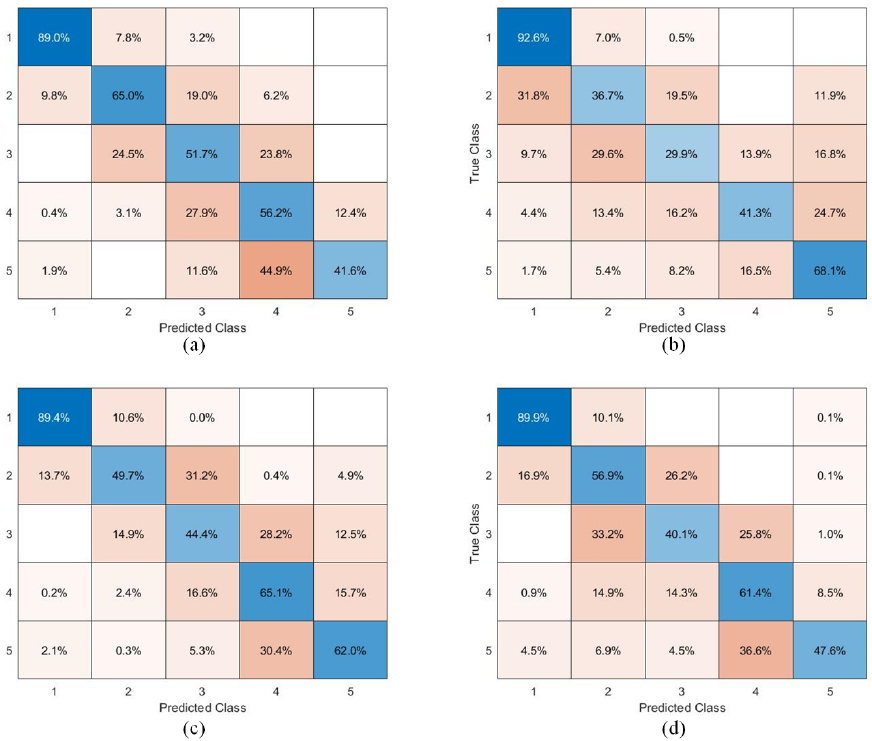
Figure 7. Confusion matrices of the best-performing ML recipes for the linear wear-state classes: ( a ) O [ m , k ] with SVM (Coarse G), ( b ) O [ m , k ] with k -NN (Cosine), ( c ) EA O with SVM (Linear) and ( d ) EA 2 with k -NN L